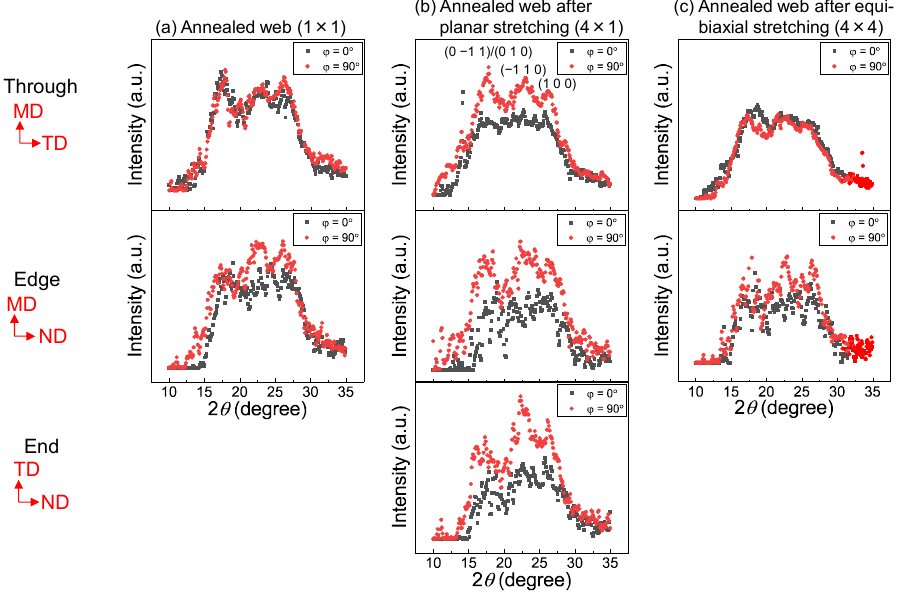
Figure 10. WAXD intensity profiles against diffraction angle for the azimuthal angles ( φ ) of 0 and 90 ◦ for the ( a ) annealed web (stretch ratio of 1 × 1), ( b ) annealed web after planar stretching (stretch ratio of 4 × 1), ( c ) annealed web after simultaneous equibiaxial stretching (stretch ratio of 4 × 4).